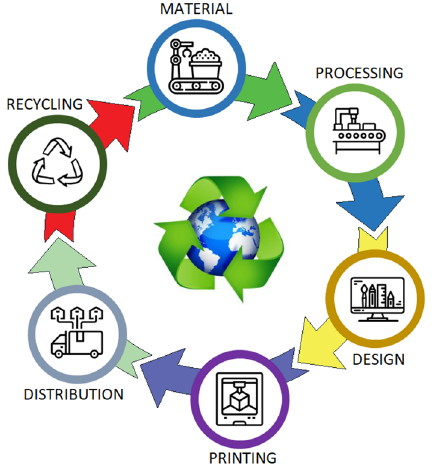
Figure 1. Life cycle of the additive manufacturing process.